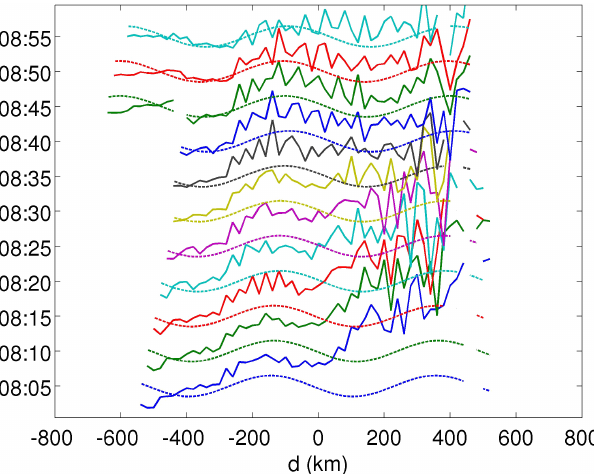
Figure 16. s p calculated from the values of arg( F) , and the fitted straight line, the gradient of which gives the resulting horizontal phase velocity v x